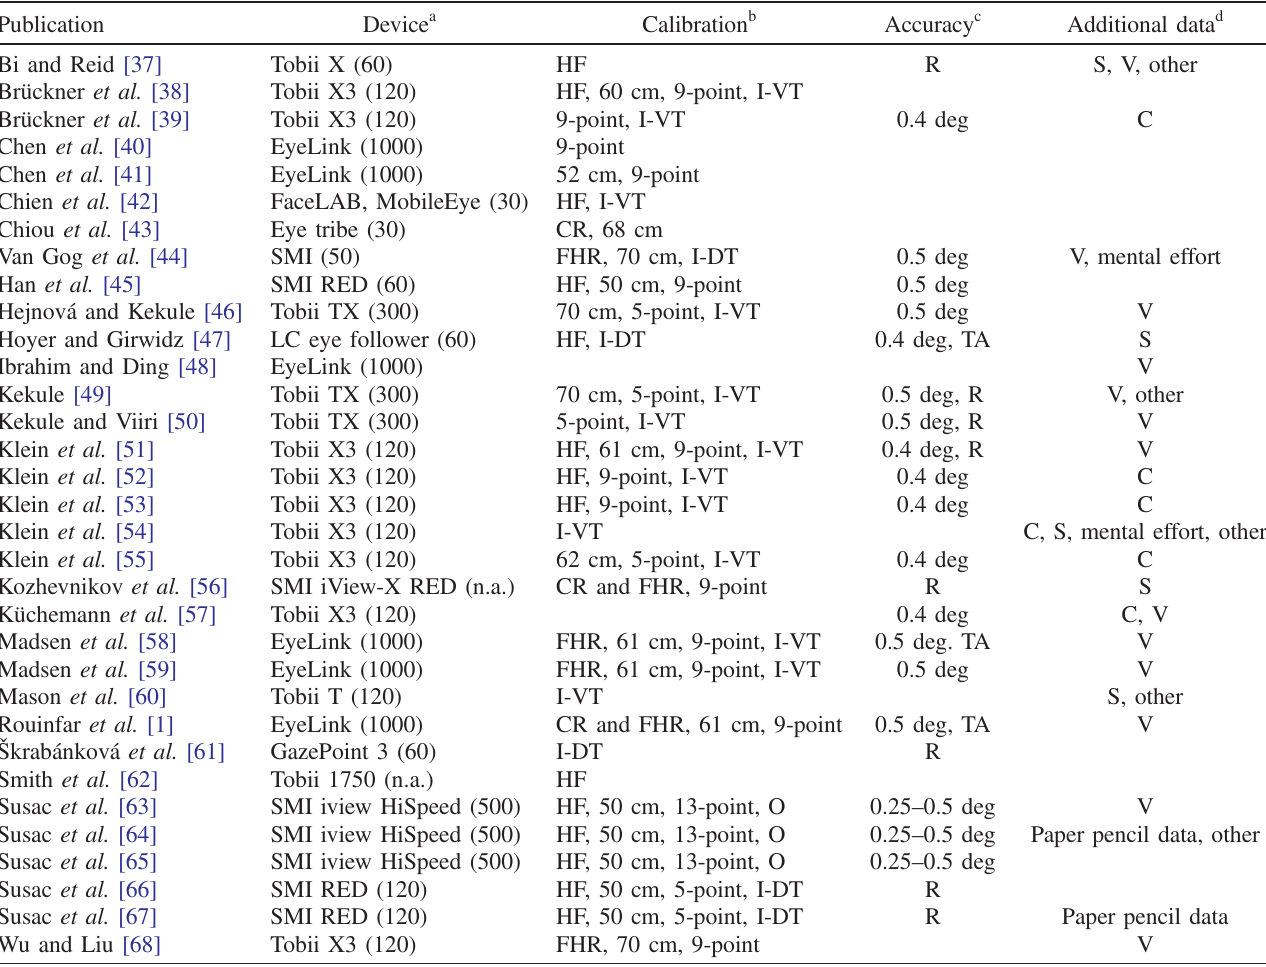
TABLE IX. Device, eye-tracking procedure information, and additional data: